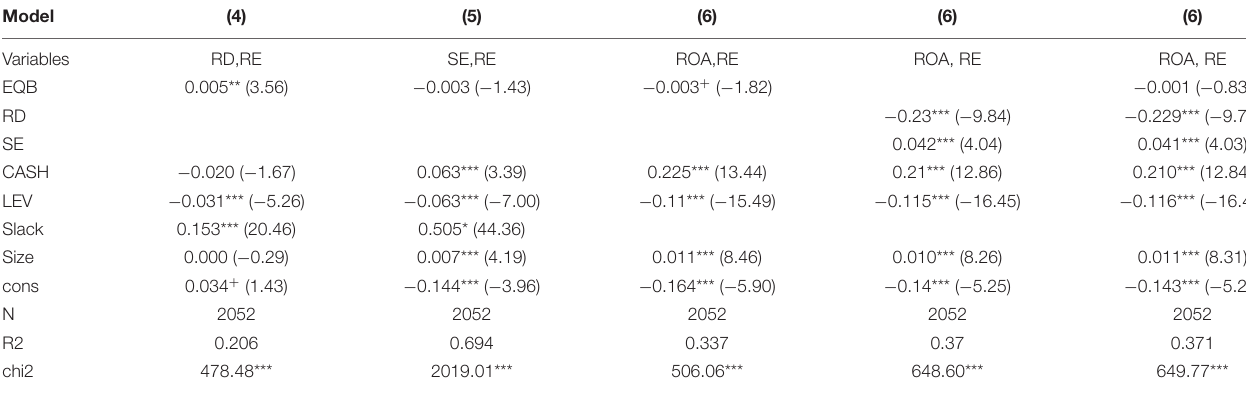
TABLE 4 | Stepwise regression